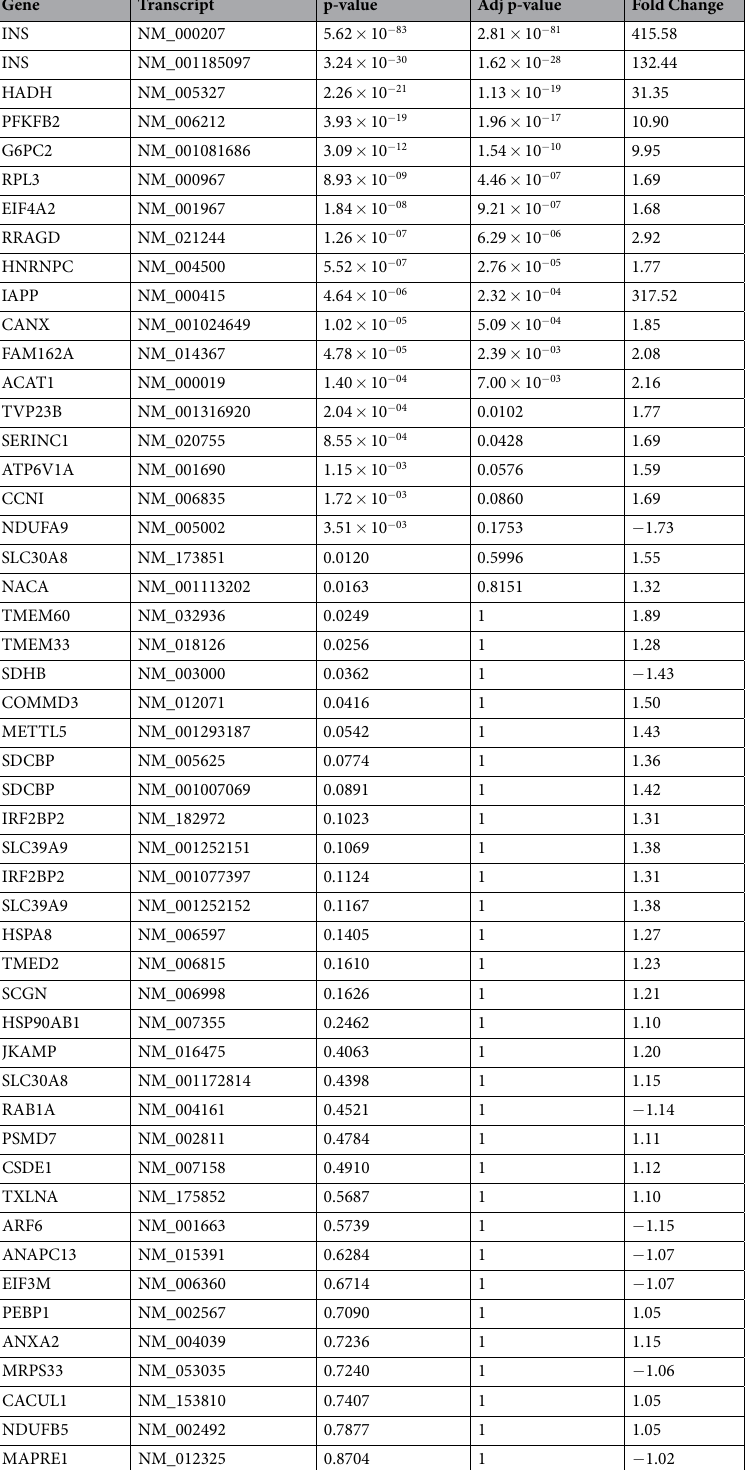
Table 3. In silico replication of unique β -cells upregulated genes reported in recent human non-diabetic islet single-cell studies 8–11 . Adjusted P-value corrected for 50 transcripts